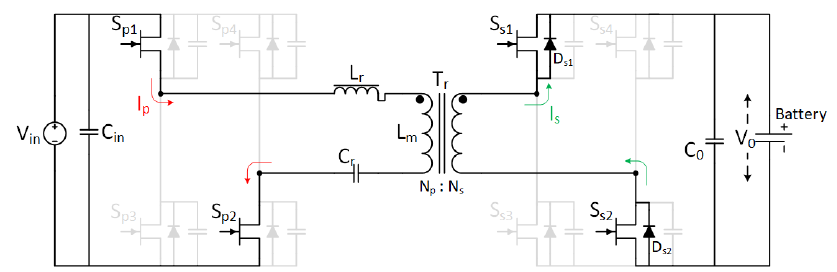
Figure A2. LLC resonant converter topology